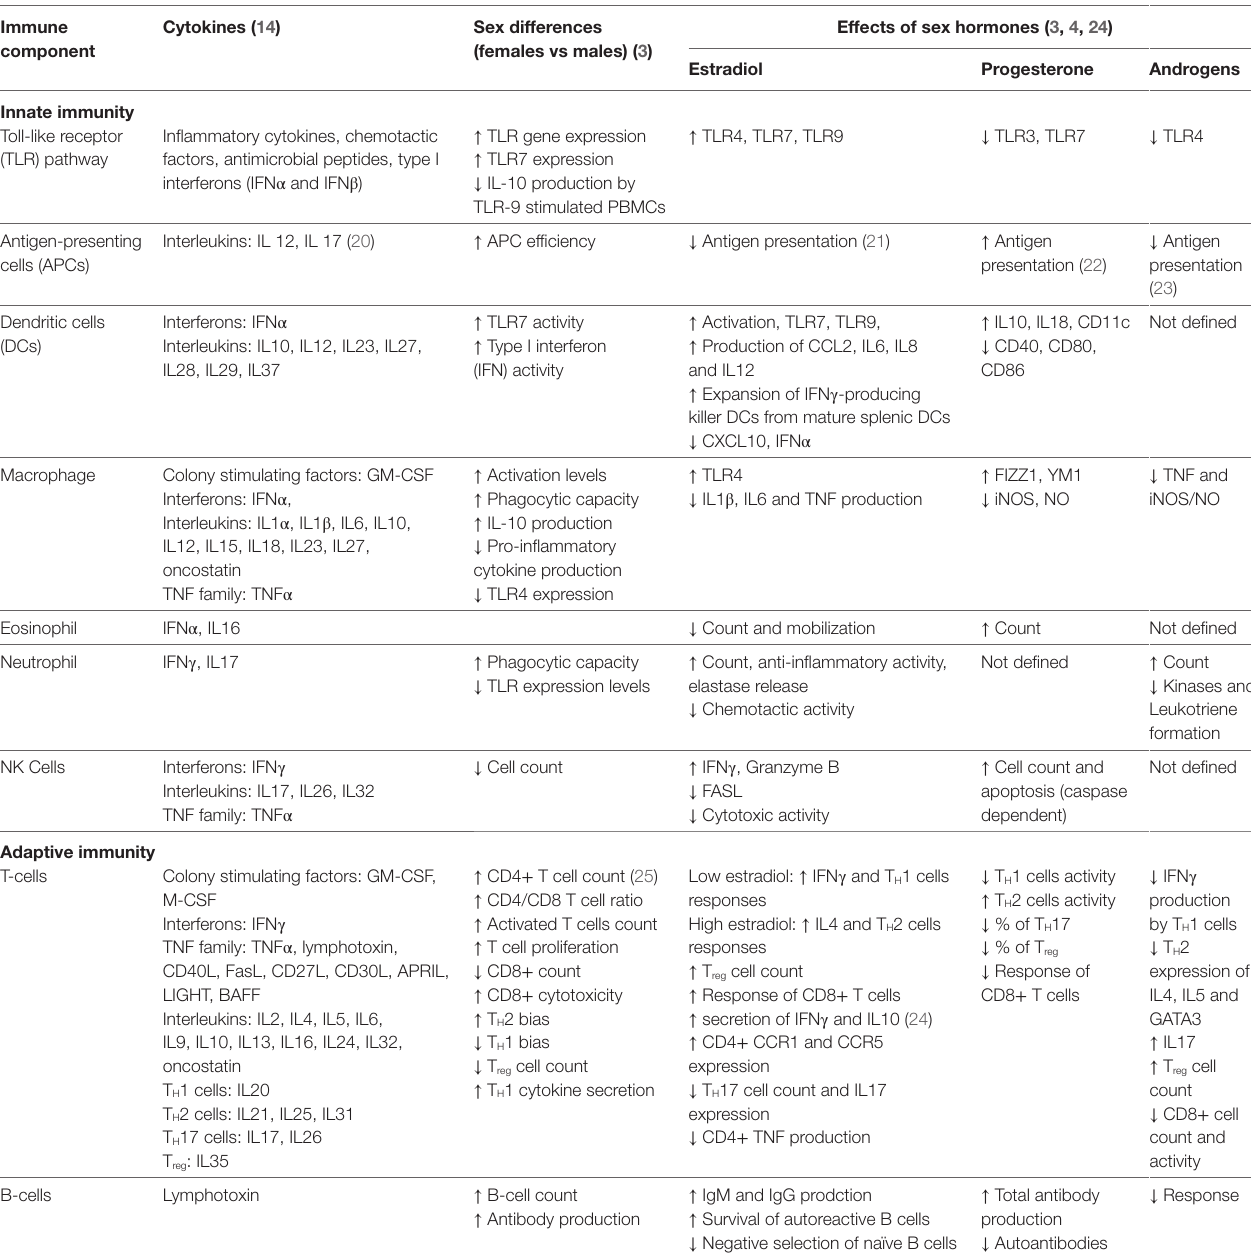
taBLe 1 | Sex dimorphism of the immune system